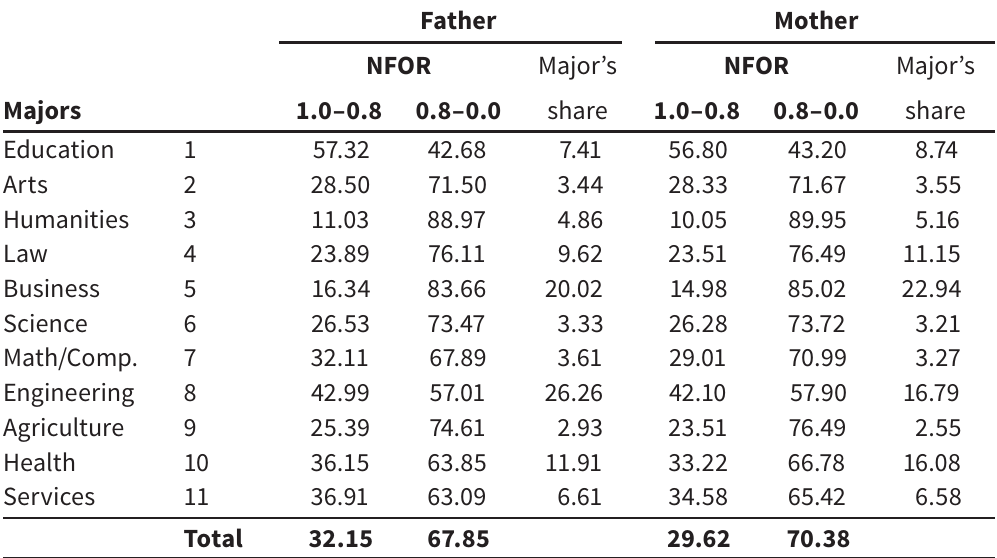
Distribution of fathers and mothers by NFOR and 12 prime CIP codes (%